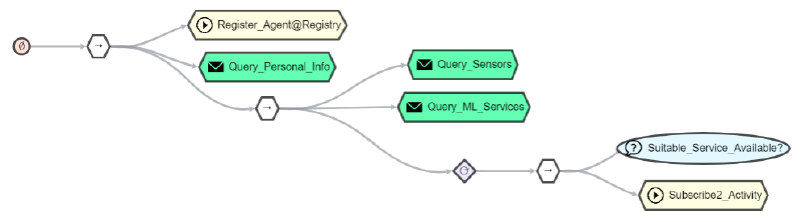
Figure 12. SBT for subscribing to ML-services and registration at the